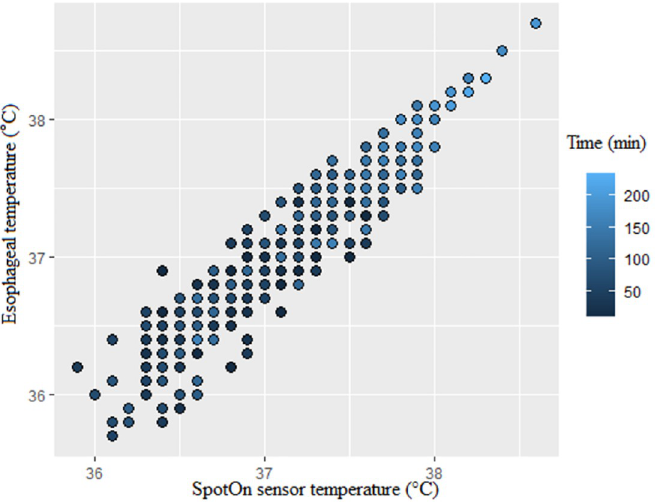
Fig 1. Scatter plot for esophageal and SpotOn temperatures (measurement time is indicated by colored circles).